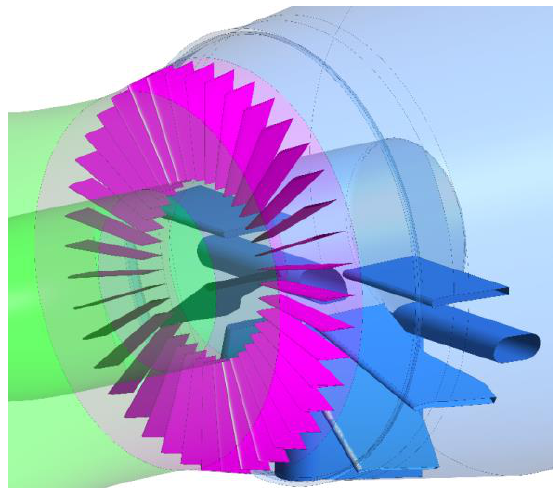
Fig. 6. Detail of the numerical model (the middle part with the blade cascade and the outlet part with diffuser internal struts).